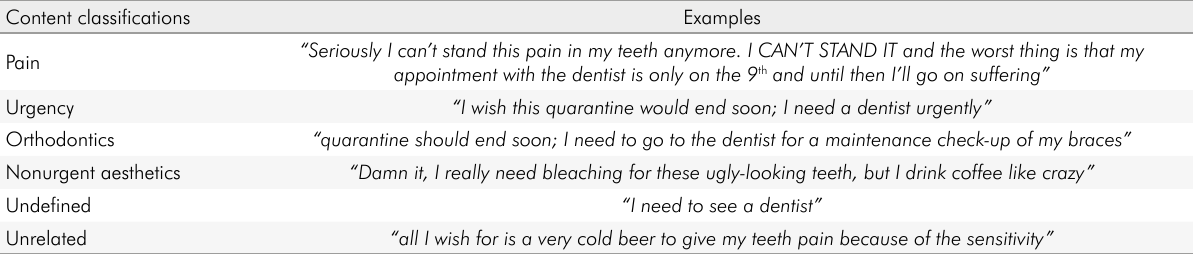
Table 1. Content classifications according to the type of dental treatment needed and examples of the extracted tweets retrieved with the predefined search